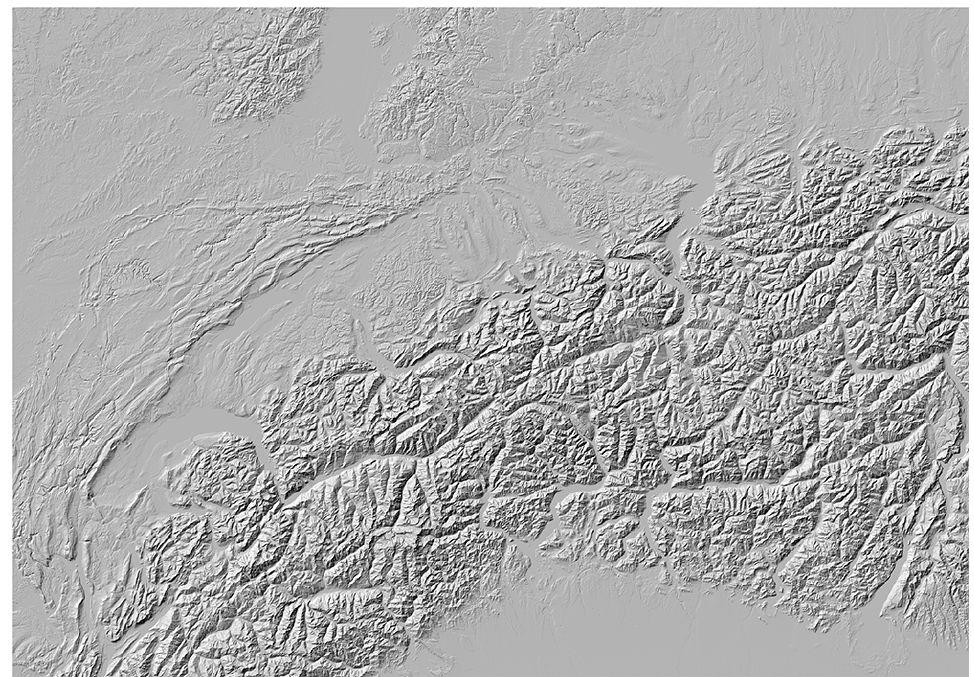
Figure 10. Traditional analytical relief shading using an illumination source from one direction (315°).